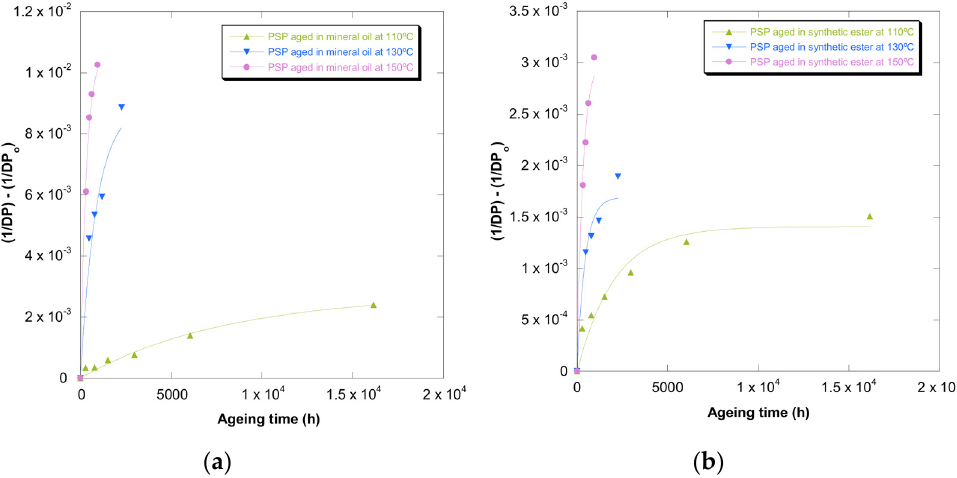
Figure 8. Evolution of the (1/DP -1/DP 0 ) as a function of temperature for pressboard PSP 3055 aged at 150 ◦ C, 130 ◦ C, and 110 ◦ C, and Zervos’ function, in mineral oil ( a ) and in synthetic ester ( b ). The values of the calculated constants (k and a) are shown in Table 6. This kinetic model had a high agreement with the experimental measures, with the coefficients of determination (R2) being slightly lower than the ones obtained with the Emsley model. Both mechanical properties ( ε cm and σ R ) and the DP allowed us to estimate the degradation of the PSP 3055 through this mathematical approach. Table 6. Constant rates of reaction for the Zervos model based on DP, ε cm, and σ R for different insulation oils. )⁄ − (1 𝑃𝑟𝑜𝑝𝑒𝑟𝑡𝑦 ))⁄ = (𝑎 100)⁄ × (2 (cid:3038)×(cid:3047) − 1) (1 𝑃𝑟𝑜𝑝𝑒𝑟𝑡𝑦 (𝐷𝑃, 𝜀 , 𝜎 (𝐷𝑃, 𝜀 , 𝜎 (cid:3030)(cid:3040) (cid:3019) (cid:2868) (cid:3030)(cid:3040) (cid:3019) Mineral oil Synthetic ester